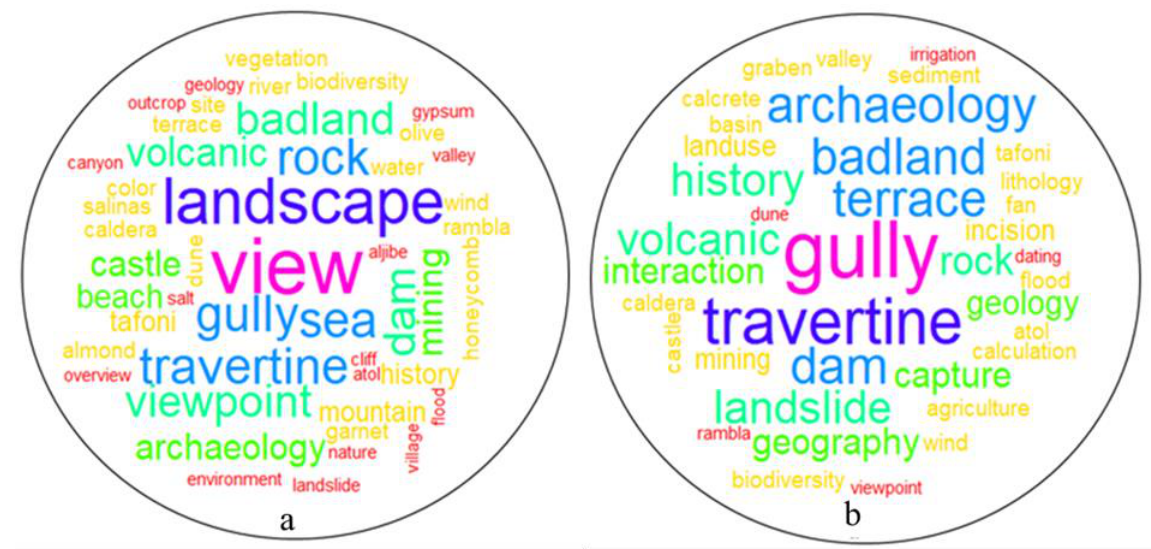
Figure 6. The most frequently reported features of geosites explaining their scenic beauty and scientific value, as mentioned by the GB-V group (29 persons). ( a ) scenic beauty (total words = 48, minimum and maximum word frequency = 5 and 146, respectively); ( b ) scientific value (total words = 38, minimum and maximum word frequency = 5 and 33, respectively). Note that the word size corresponds to the frequency of that word in its category, i.e., in scenic beauty or scientific value.